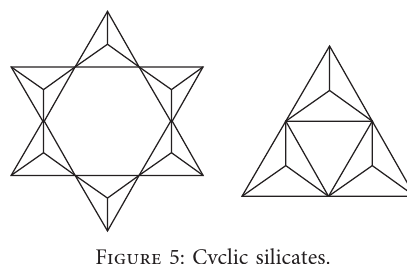
Figure 5: Cyclic silicates.